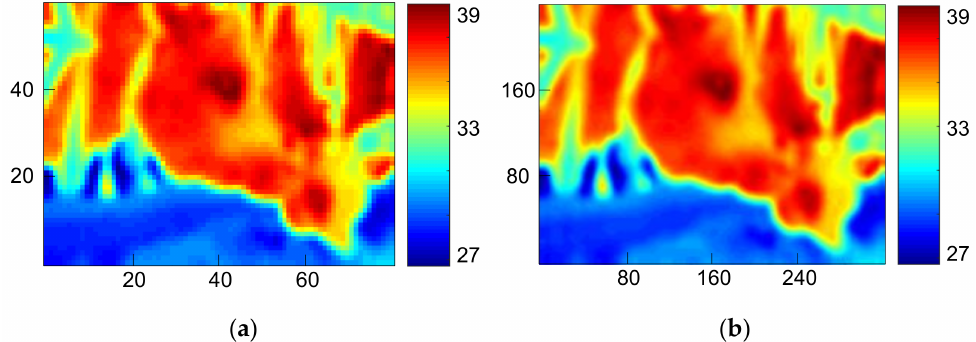
Figure 7. IRT frame processing. ( a ) Original IRT picture. ( b ) After the bilinear